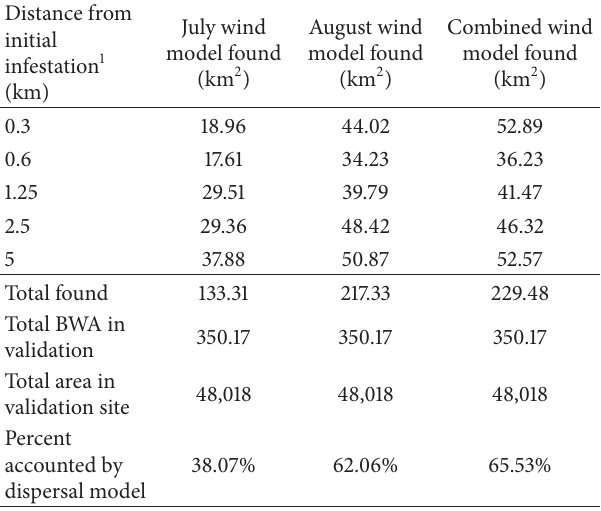
Table 1: Predicted new BWA dispersal in validation